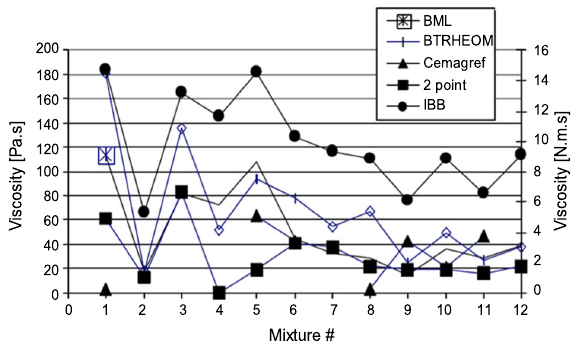
Fig. 1. Values of rheological parameters (K and μ) identified on the 12 concretes studied by (Banfill et al . 2001) with different